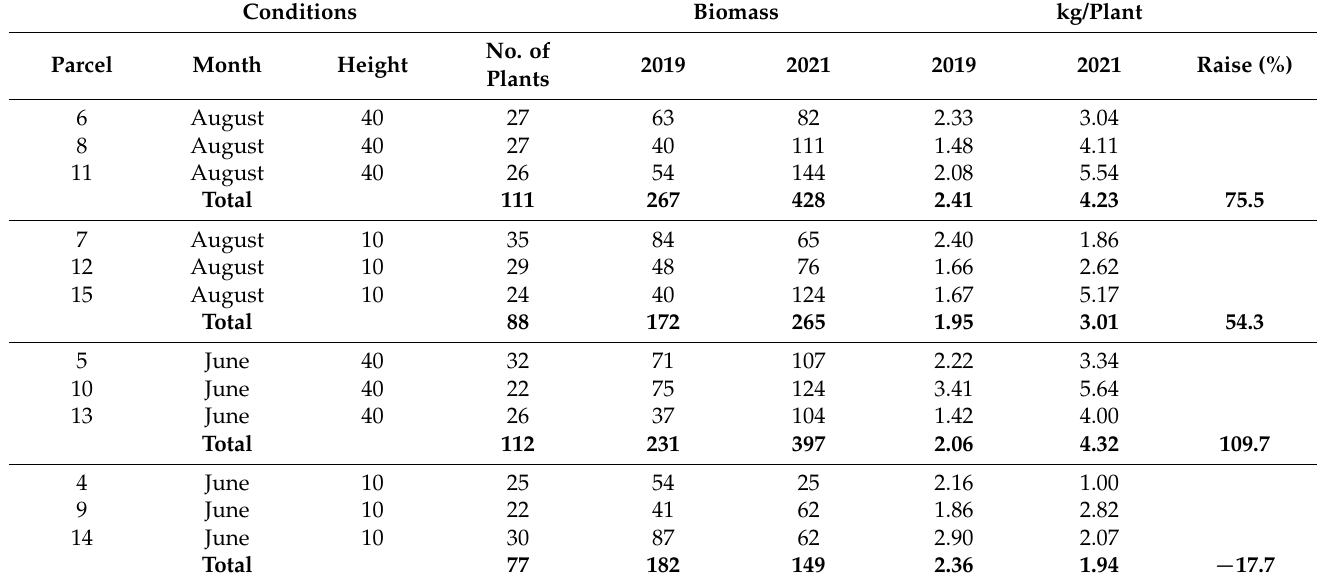
Table 3. Yerba-mate biomass production in two different moments: at the start of the experiment and after two years of the